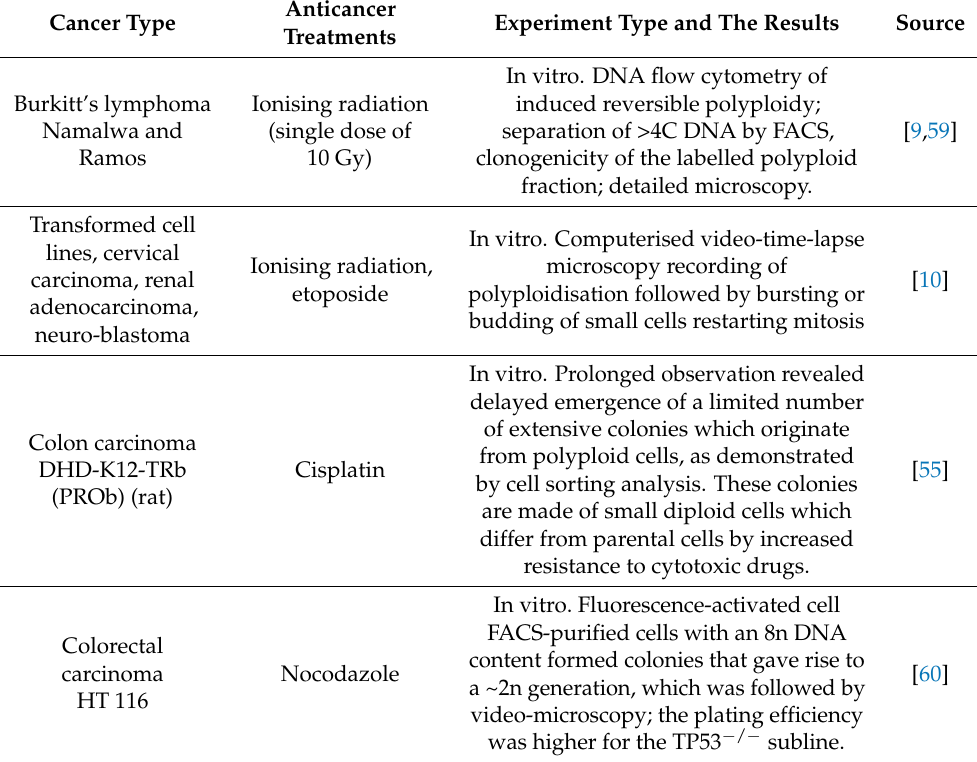
Table 1. A summary of experimental evidence for anticancer treatment resistance acquired via reversible polyploidisation of mammalian cancer cells (where the species is not indicated, human material was investigated). PGCC—polyploid giant cancer